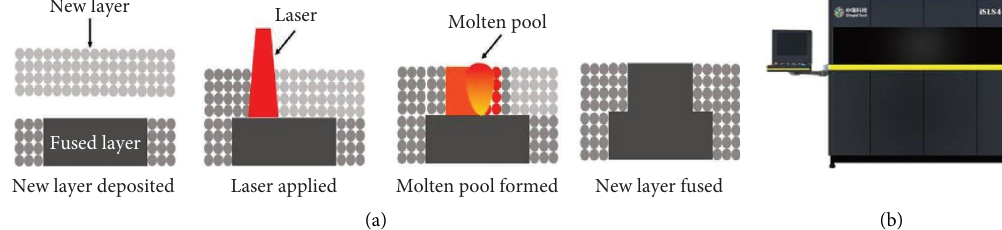
Figure 6: SLS printing principle (a) and equipment (b).